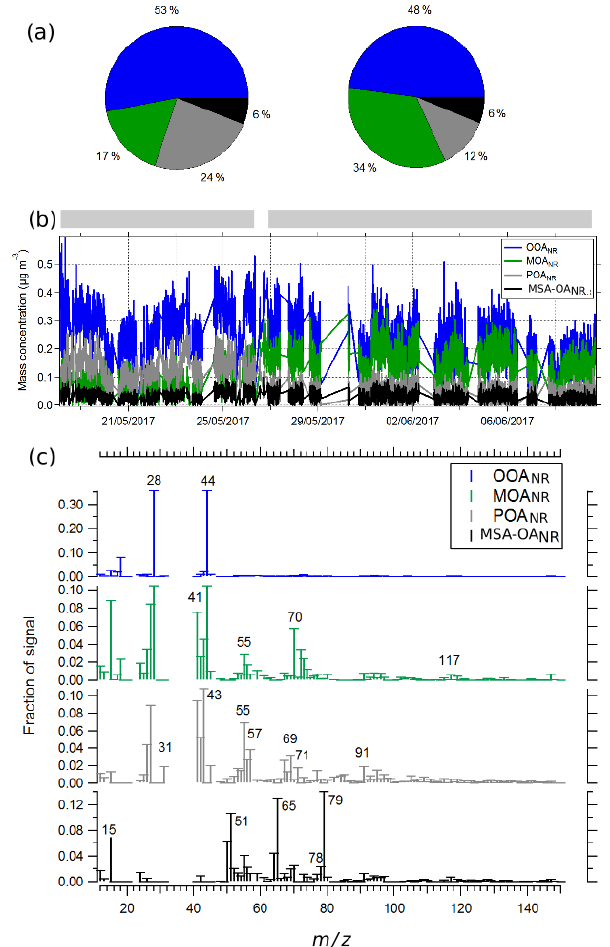
Figure 4. (a) The contribution of the different organic factors during different periods of the PEACETIME ship campaign (identified by the grey bars at the top of b ). (b) The mass concentrations of each factor (OOA NR , MOA NR , POA NR , and MSA OA NR ) as a function of time. (c) The mass spectra of the